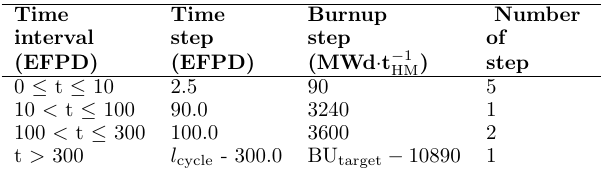
Fig. 5. Loading pattern used in 3D full-core modeling of heterogeneous PWR core. The 26 fuel assemblies indicated correspond to combustion zones composing one eighth of the core. Table 8. Core geometrical data. Table 9. Time discretization for full-core